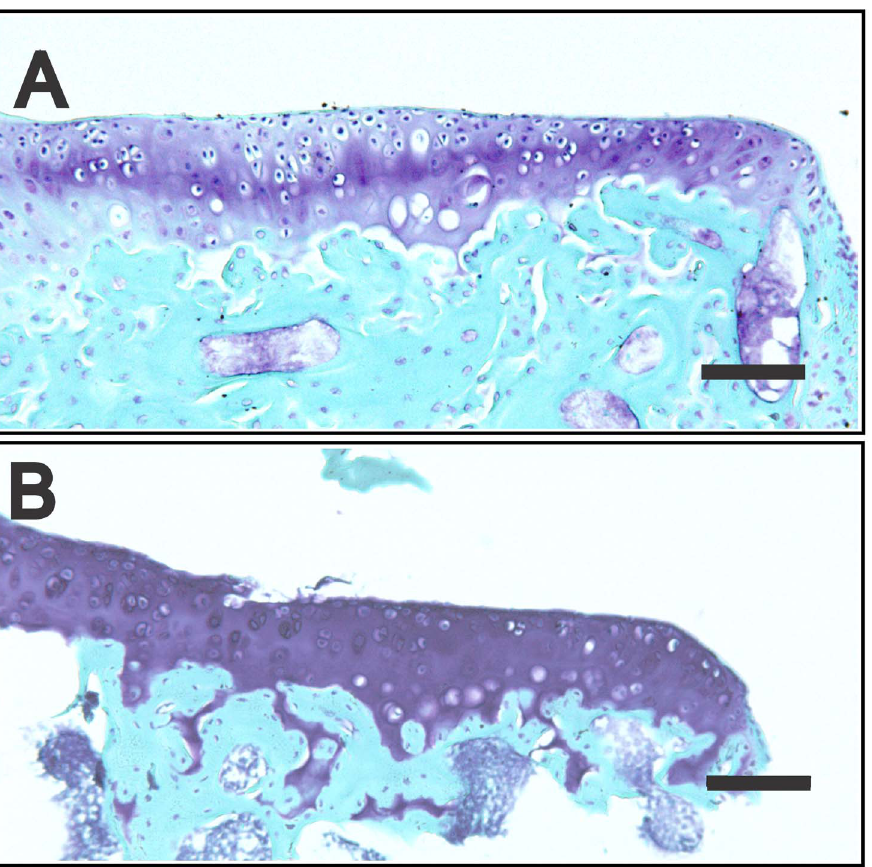
Figure 3. Cartilage morphology after EDTA or RNA later /EDTA decalcification. Tibial epiphyses were decalcified for 72 hrs at 4 u C with 0.5 M EDTA (A) or RNA later /10% EDTA at pH 5.2 and cryosections were stained with toluidine blue/fast green. The medial tibial plateau is shown. Cartilage morphology and aggrecan staining is preserved in the RNA later /10% EDTA, pH 5.2 decalcified samples. Scale bar=100 m m.